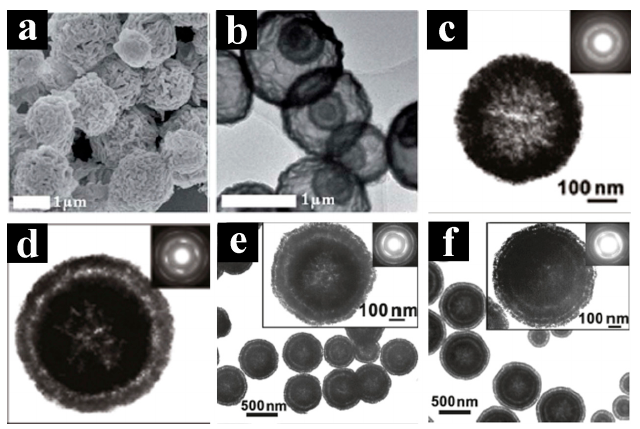
Figure 9. Graphical illustration of multi–shells structure synthesized by self-templating method: ( a ) scanning electron microscopy (SEM) and ( b ) transmission electron microscopy (TEM) images of the CeO 2 triple-shelled hollow spheres (TSHSs). TEM images of the Cu 2 O ( c ) single-shelled hollow spheres (SSHSs), ( d ) double-shelled hollow spheres (DSHSs), ( e ) TSHSs, and ( f ) quadruple-shelled hollow spheres (QSHSs). Pictures ( a ), and ( b ) were reprinted with permission from Reference [152]. Copyright American Chemical Society, 2014. Pictures ( c ), ( d ), ( e ), and ( f ) were reprinted with permission from Reference [153]. Copyright American Chemical Society, 2011.